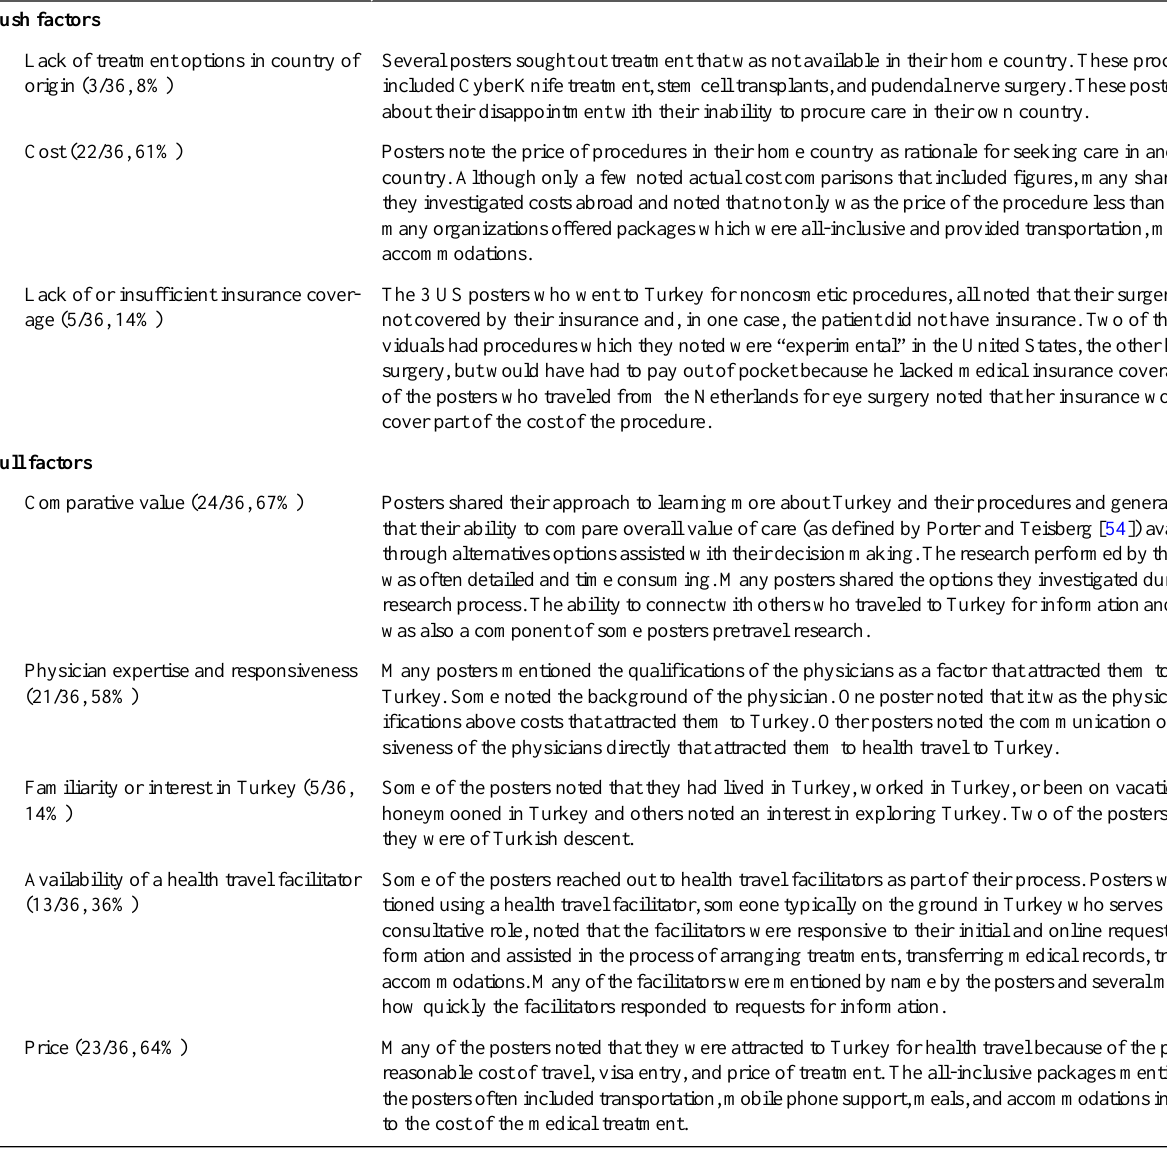
Table 4. Push and pull factors for patients who traveled to Turkey for medical